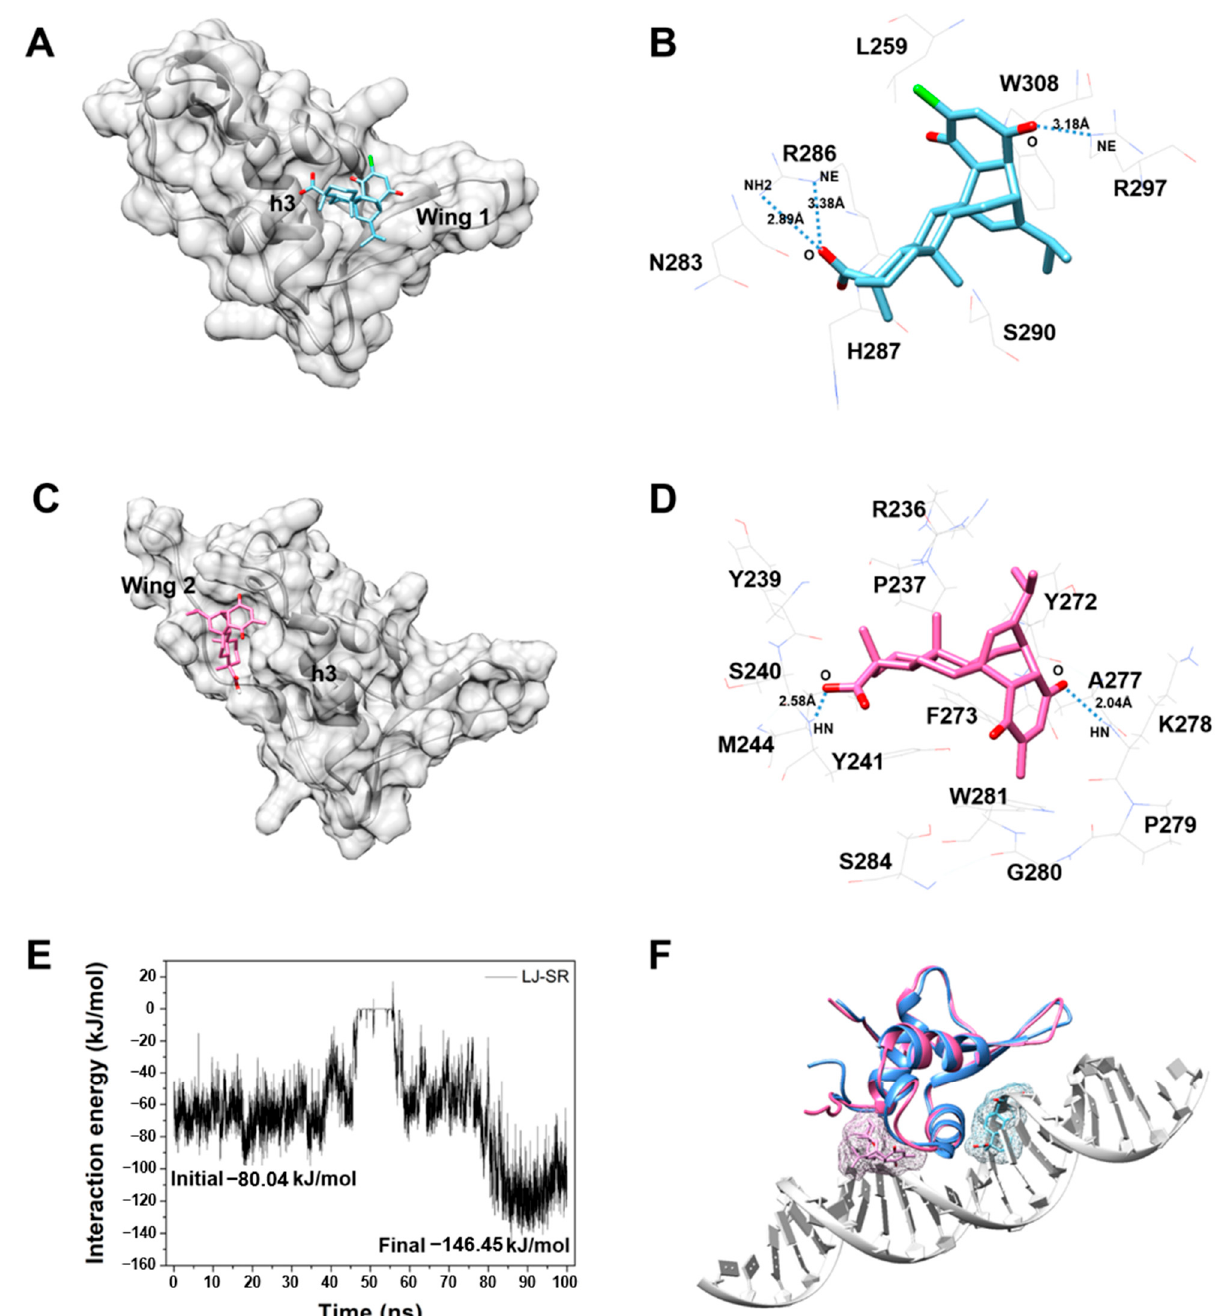
Figure 7. Computational simulation results involving interaction between CDI and FoxM1-DBD. ( A ) Docking result structure with the lowest energy. FoxM1-DBD is represented by the grey ribbon and surface, CDI is represented by the blue stick. ( B ) Interaction residues from docking results. Wire sticks are interacting residues. Dotted line indicates hydrogen bonds. ( C ) The structure from MD result. A grey ribbon and surface model is a FoxM1-DBD structure, and a pink stick represents CDI. ( D ) Interaction residues from MD results. Wire sticks are interacting residues. Dotted lines indicate hydrogen bonds. ( E ) Protein-ligand interaction energy profile obtained using 100 ns simulation. ( F ) Binding position comparison between docking and MD simulations. Blue structure is from the docking result and pink structure is from the MD result. Chimera program was used for drawing 3D structures